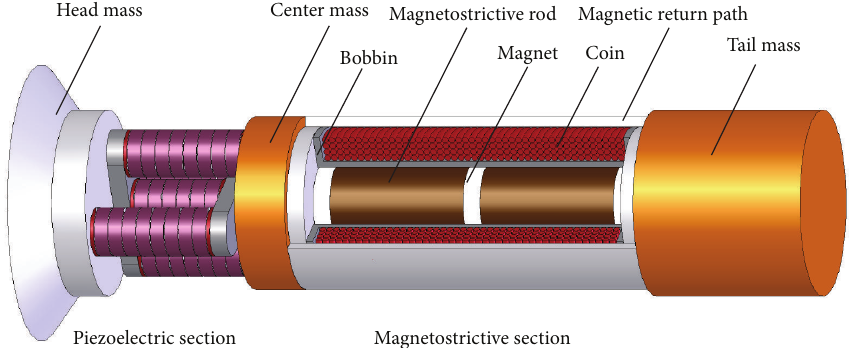
Figure 1: Schematic diagram of the Hybrid